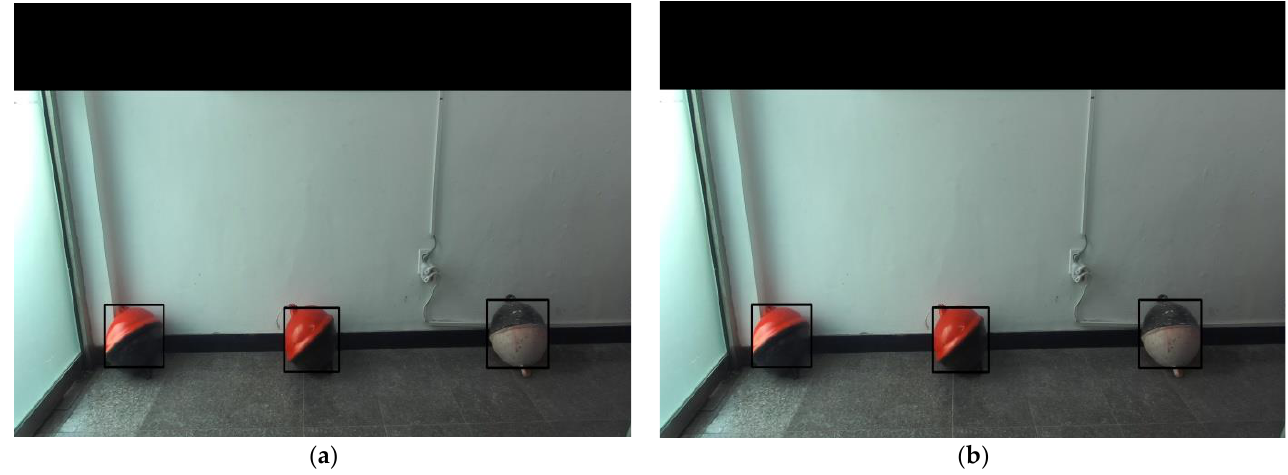
Figure 14. Detecting results (Experiment A).